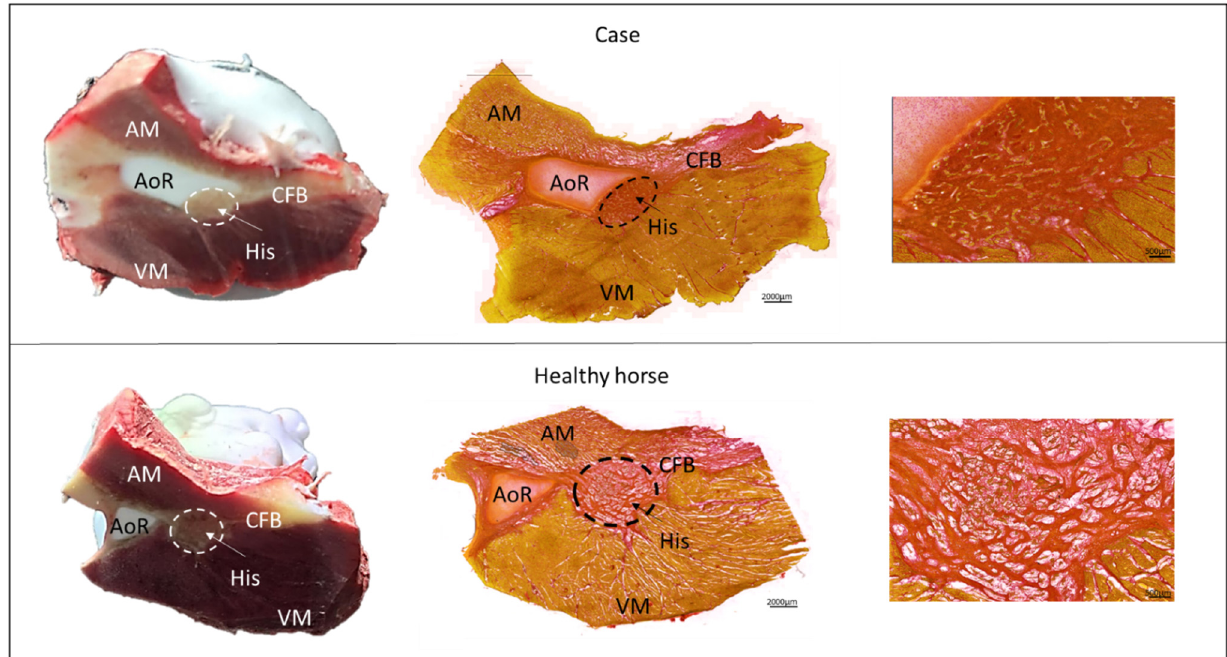
Figure 4. Tissue sample of the atrioventricular node and His bundle. ( Left ): Representative images of transvers sectioning of the AV nodal region from the case and a healthy horse. The very prominent cartilaginous aortic root was already visible macroscopically. ( Middle ): Sirius red histology of the AV node when it transits through the CFB corresponding to the His bundle. Red is collagen whereas yellow is cardiomyocytes. The black encircled area is the His bundle. White areas within the tissue are artifacts induced by freezing of the tissue. ( Right ): Magnified view of the His bundle. Note the very compact bundle and the large cartilaginous part of the AoR in the case horse. AM: Atrial myocardium, AoR: Aortic root, CFB: Central fibrous body, VM: Ventricular myocardium.